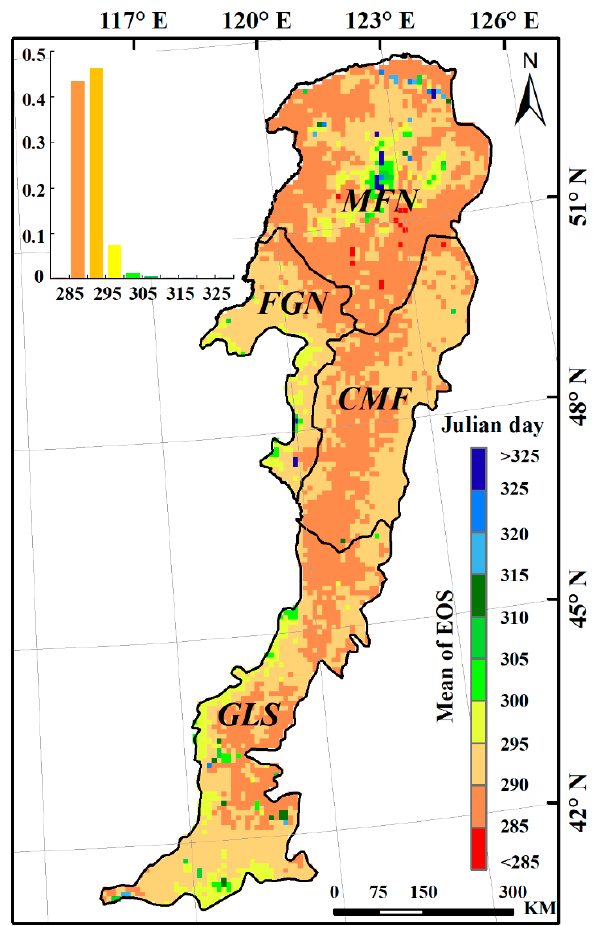
Figure 5. Spatial distribution of EOS in the Greater Khingan Mountains during the period 1982–2015.